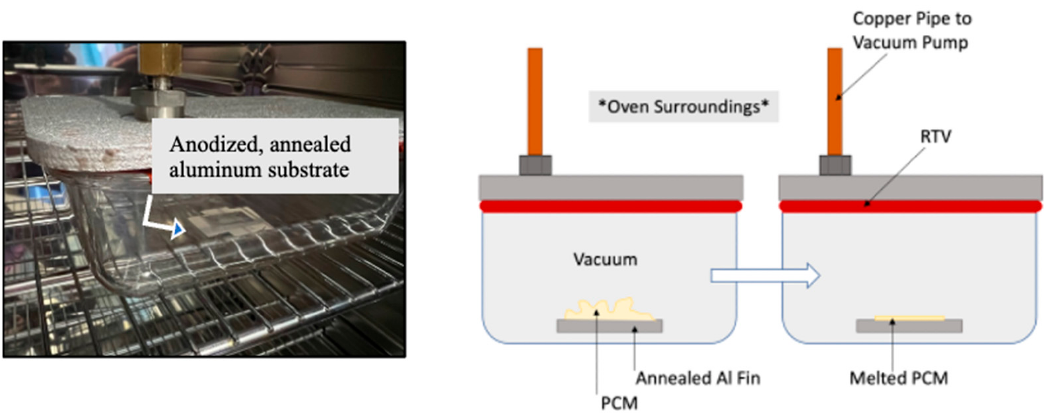
Figure 3. Vacuum impregnation of PCM into porous anodic layer inside an oven. Left: Picture of the sample, location indicated by arrow, inside a hermetically sealed container connected to a vacuum pump while heated inside an oven. Right: Schematic representation of the PCM melting under vacuum to produce a thin layer with standard air designated by the note *Oven Surroundings*.